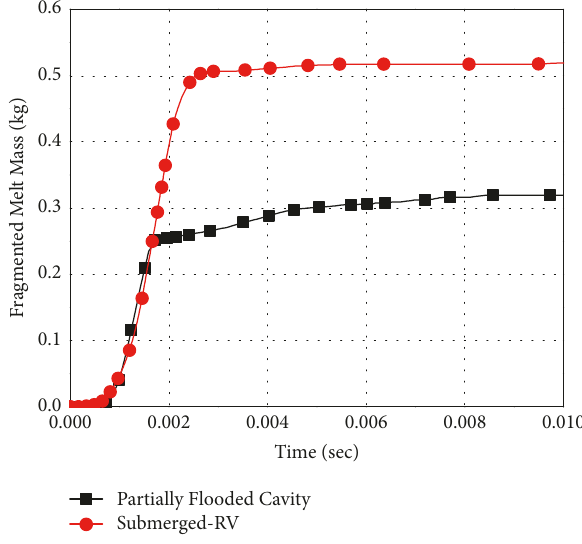
Figure 16: Finely fragmented melt mass during steam explosion in both